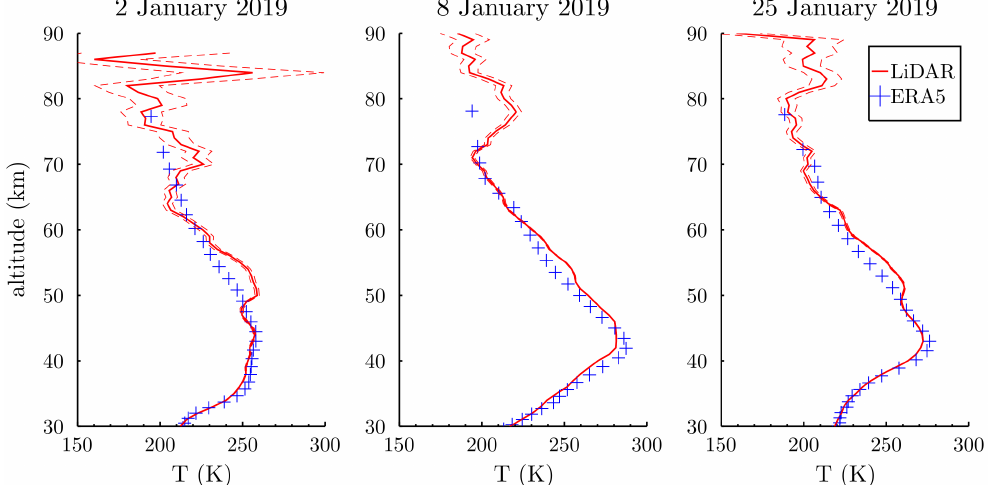
Figure 1. Temperature profiles from the LiDAR (red solid line) and the ECMWF (blue cross) for three dates selected in January 2019 during an SSW event. Instrumental errors from the LiDAR (red dashed lines) are added as